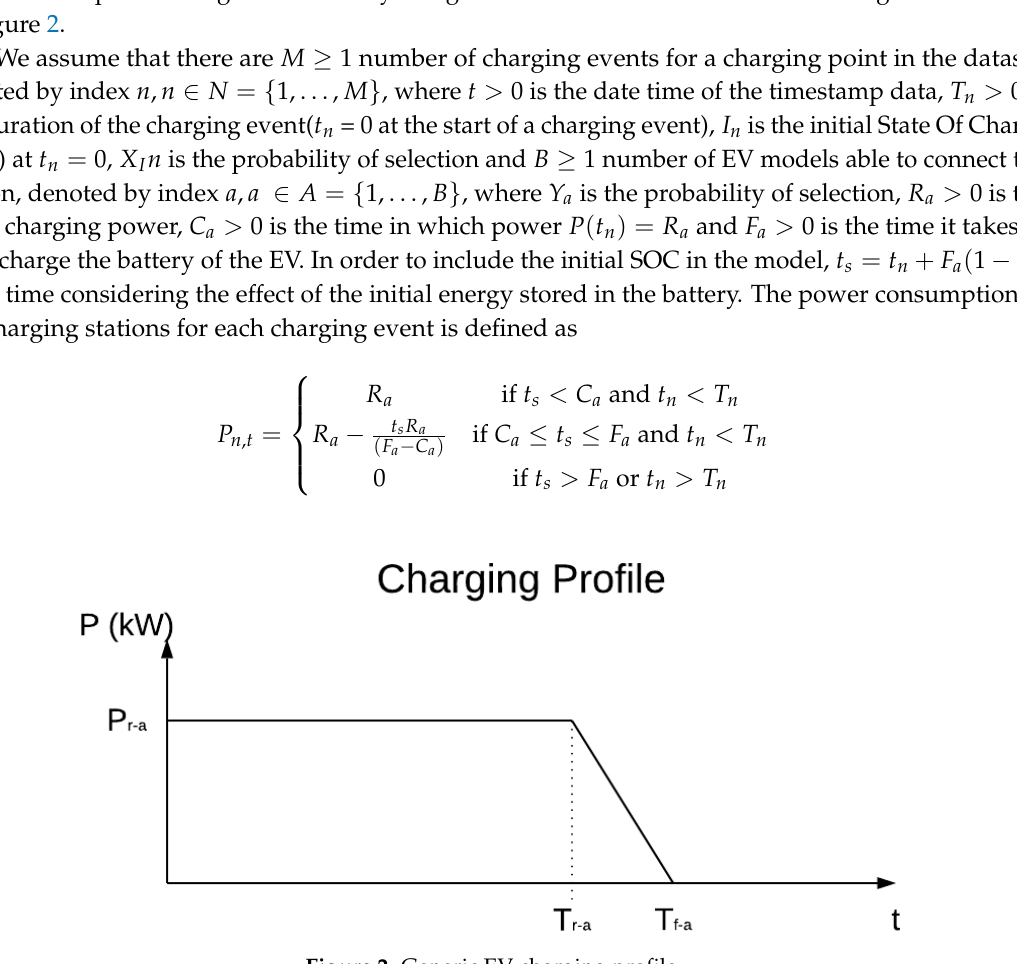
Figure 2. Generic EV charging